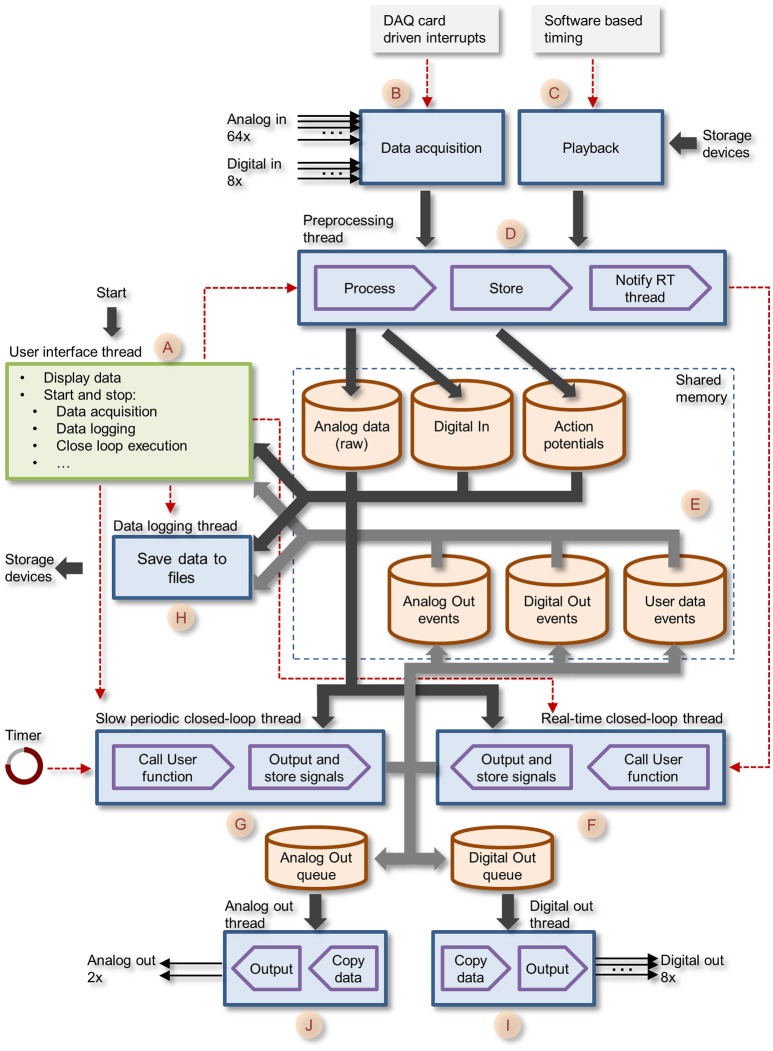
Block diagram of CLEM showing the different threads and central memory repositories. The GUI thread is shown in green, all core function threads are shown in blue. Data paths are shown as thick arrows. Control lines are shown as red dashed lines.